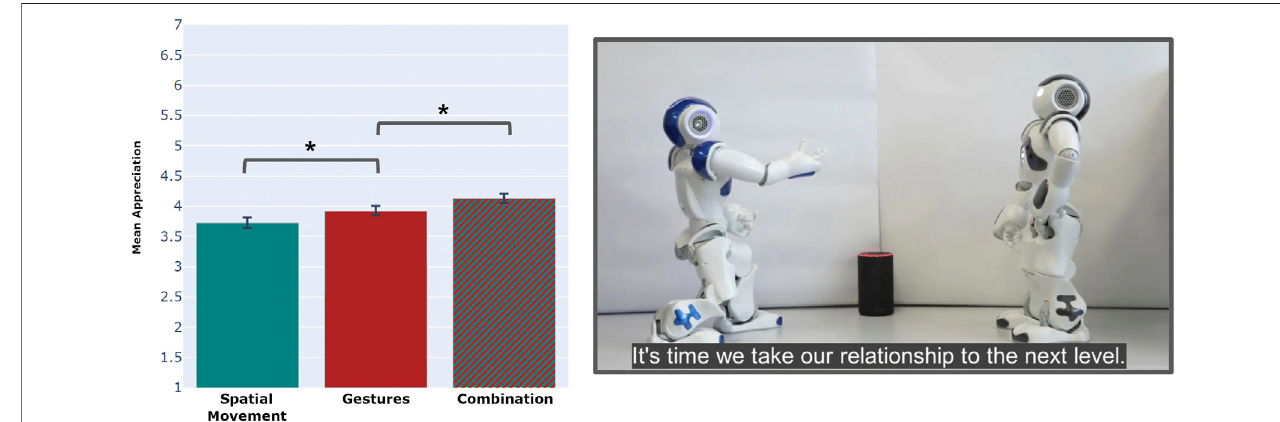
FIGURE6 | Scenario and results using the performanceframework . Thegraph shows that acombined spatial and gesture performancereceivesahigher average rating on a questionnaire assessing Human-Robot interaction utility measures. The star indicates a signi fi cant difference between the mean values ( p < 0 . 05) and the whiskers show the standard error of the mean. The image on the right shows an example of an iconic gesture performed by one of the robots during the evaluated performance.